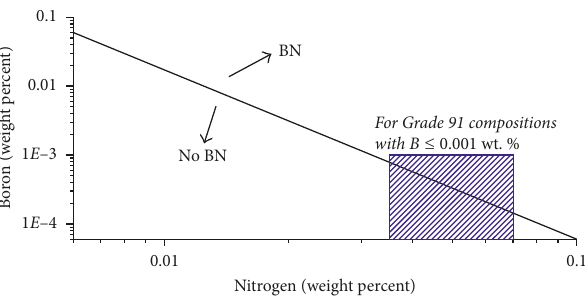
Figure 9: Relationship developed for the formation of BN in Grade 92 steel with different levels of B and N based on previous research [33]. The blue hashed box shows the range of N typically specified in Grade 91 steel for a B level of 0.001 weight ≤